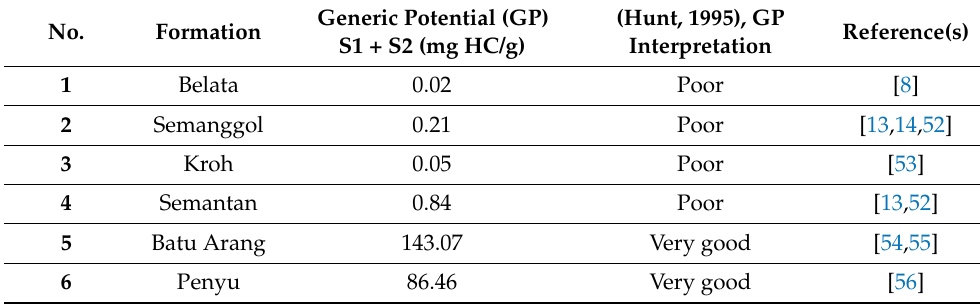
Figure 8. Tmax vs. HI plot showing level of kerogen maturity of formations in PM. Table 7. Interpretation of average GP values of formations in PM according to Hunt